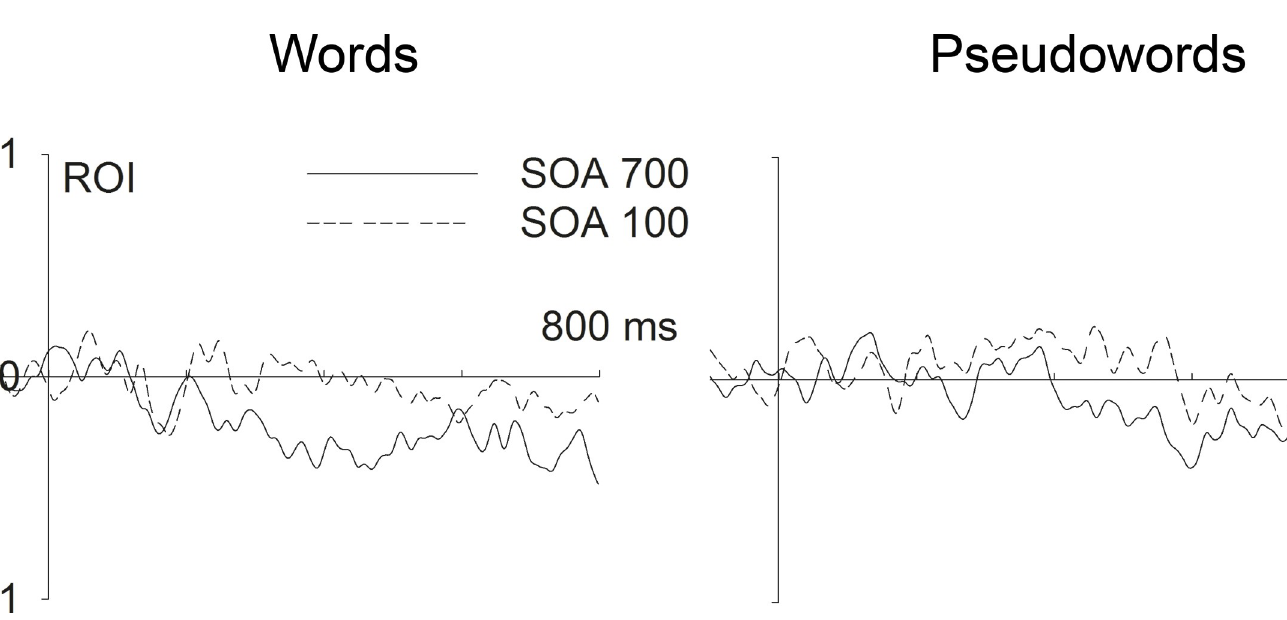
PLOS ONE | https://doi.org/10.1371/journal.pone.0199084 January 25,